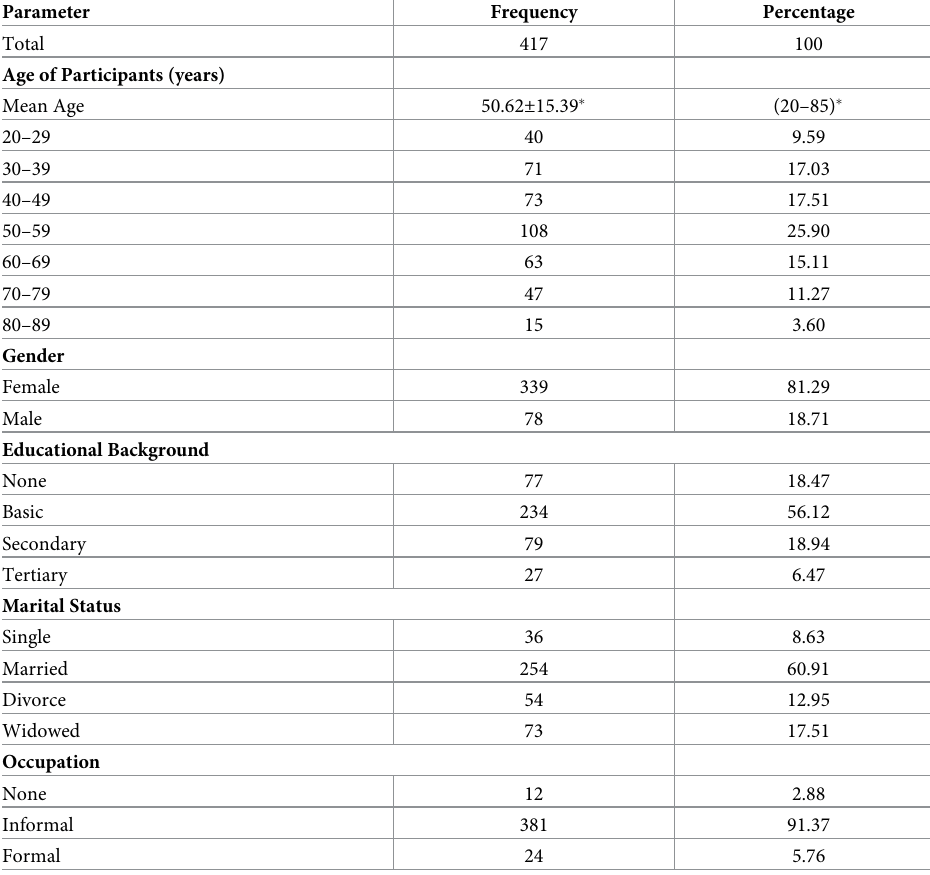
Table 1. Demographic characteristics of residents of the Nyive